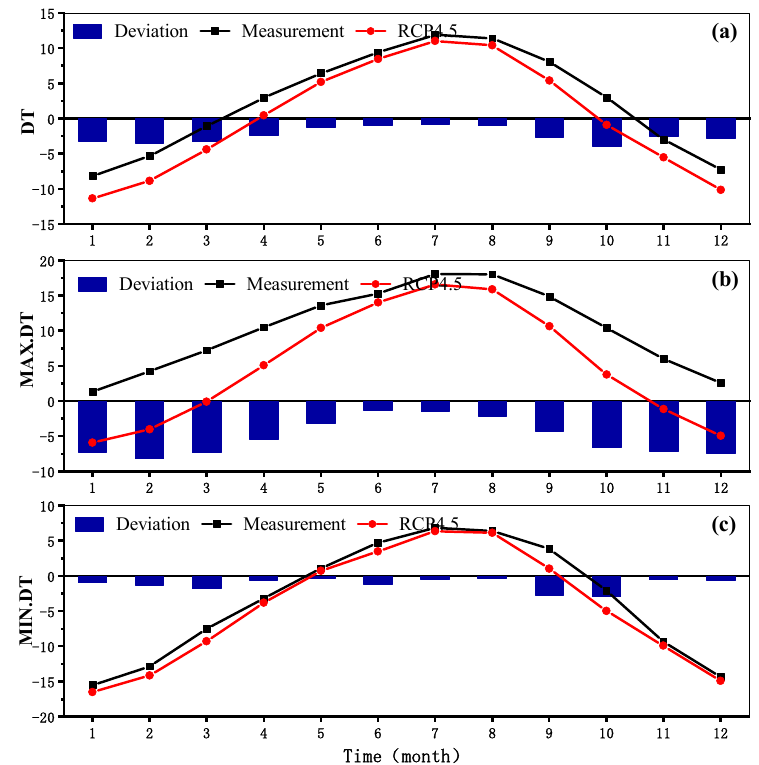
Figure 2. The bias between the observed temperature and simulated temperature in the RCP4.5 scenario in the upper Taohe River Basin. ( a ) Average temperature, ( b ) Maximum temperature, ( c ) Minimum temperature.